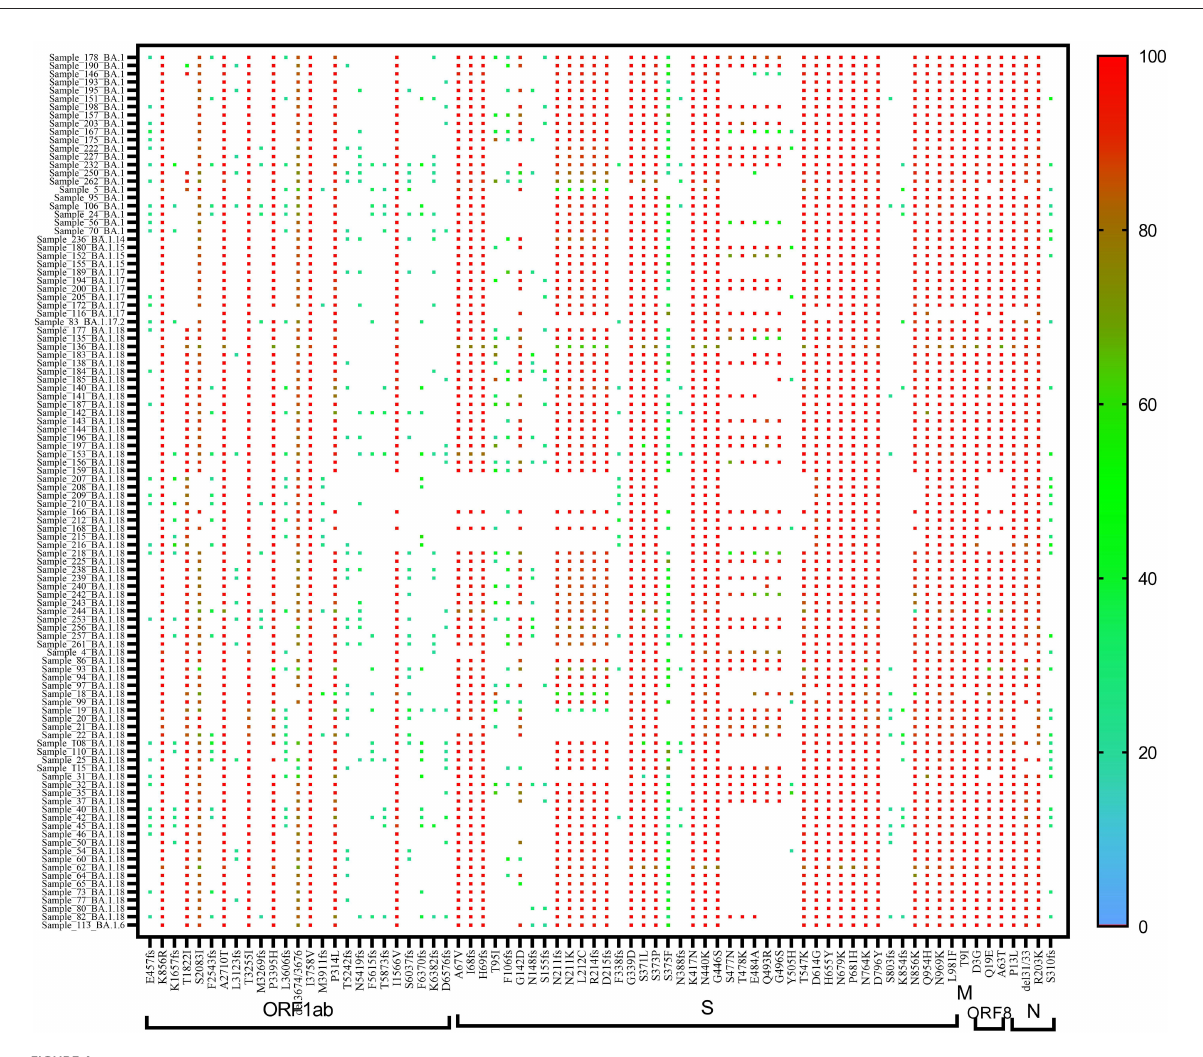
FIGURE4 Heat map of Omicron (BA.1 and derivative)